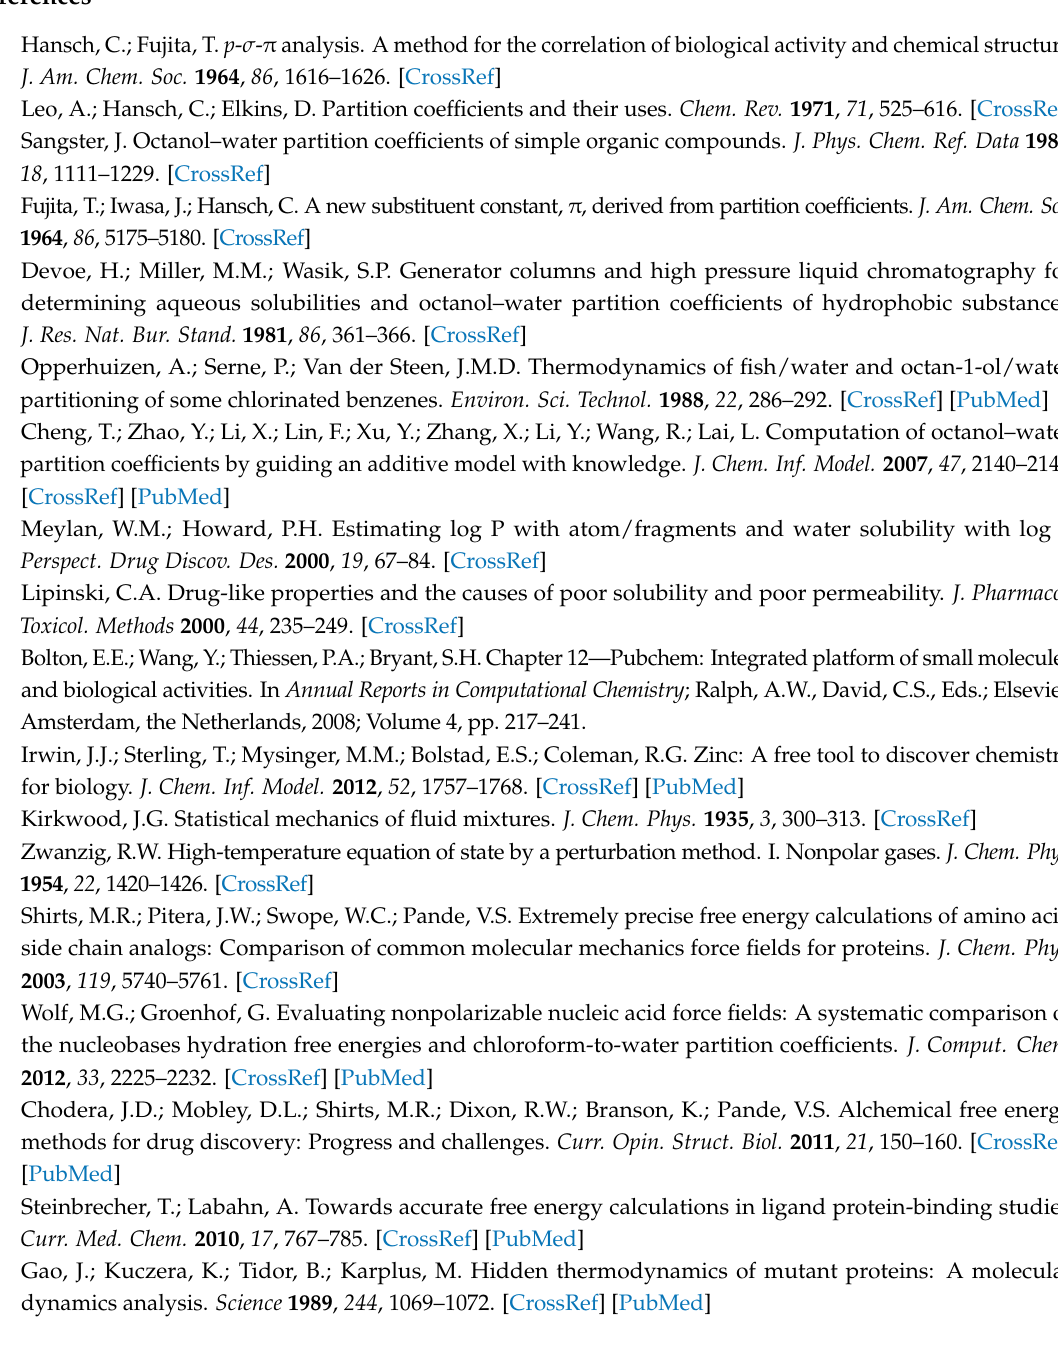
constant values in quantum chemistry calculation. Figure S2: Scatter diagram of calculated and experimentally measured log P ow values, and Figure S3: Bar graph of R 2 values for log P ow . Figure S4: RMSE of log P ow for five compounds (dimethyl sulfide, ethyl phenyl ether, naphthalene, 1-nitropropane, and tribromomethane) calculated using different methods and basis